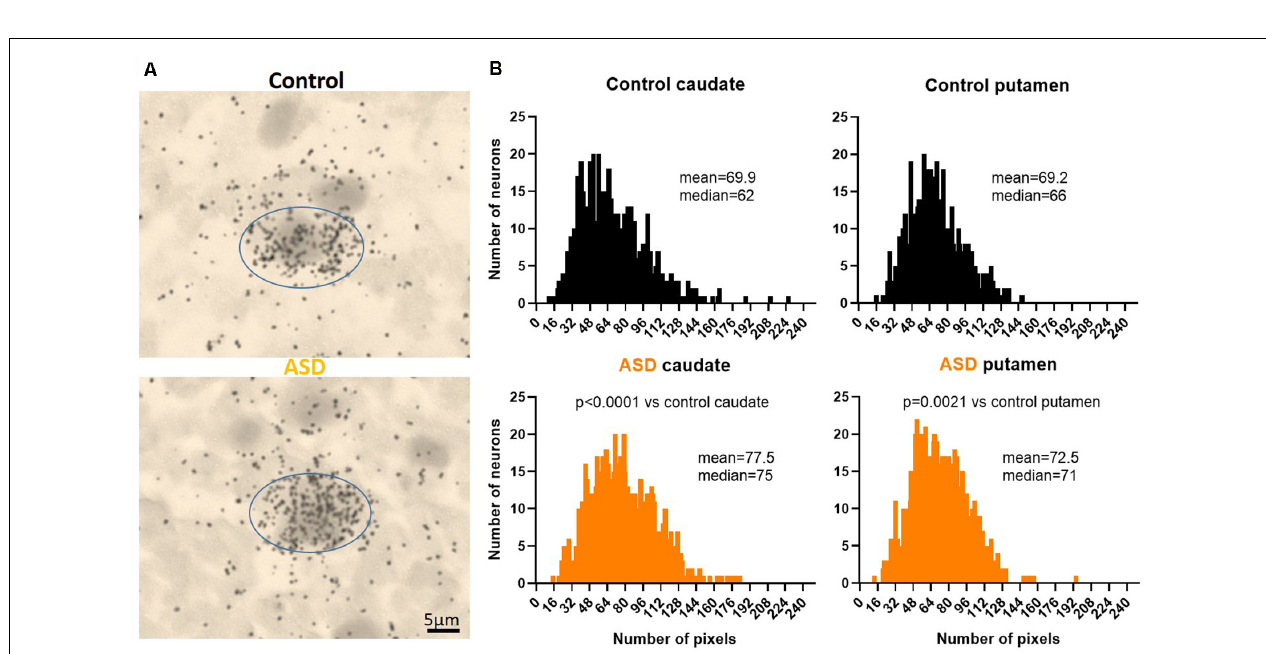
FIGURE 1 | (A) Radioisotopic in situ hybridization histochemistry showing labeled mRNA of Drd2 and Drd1. (B) Quantification of the relative density of Drd2 measured on film autoradiographs reveals higher expression in autism spectrum disorder (ASD) cases (orange) in both the caudate and putamen. Drd1 expression levels are unchanged in the caudate and putamen in ASD. Drd2 n = 11 control, 11 ASD; Drd1 n = 11 control, 10 ASD.